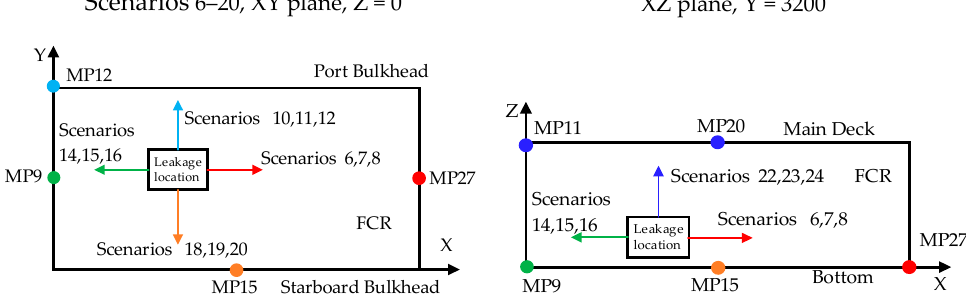
Figure 12. Monitoring points identified for different leakage directions.